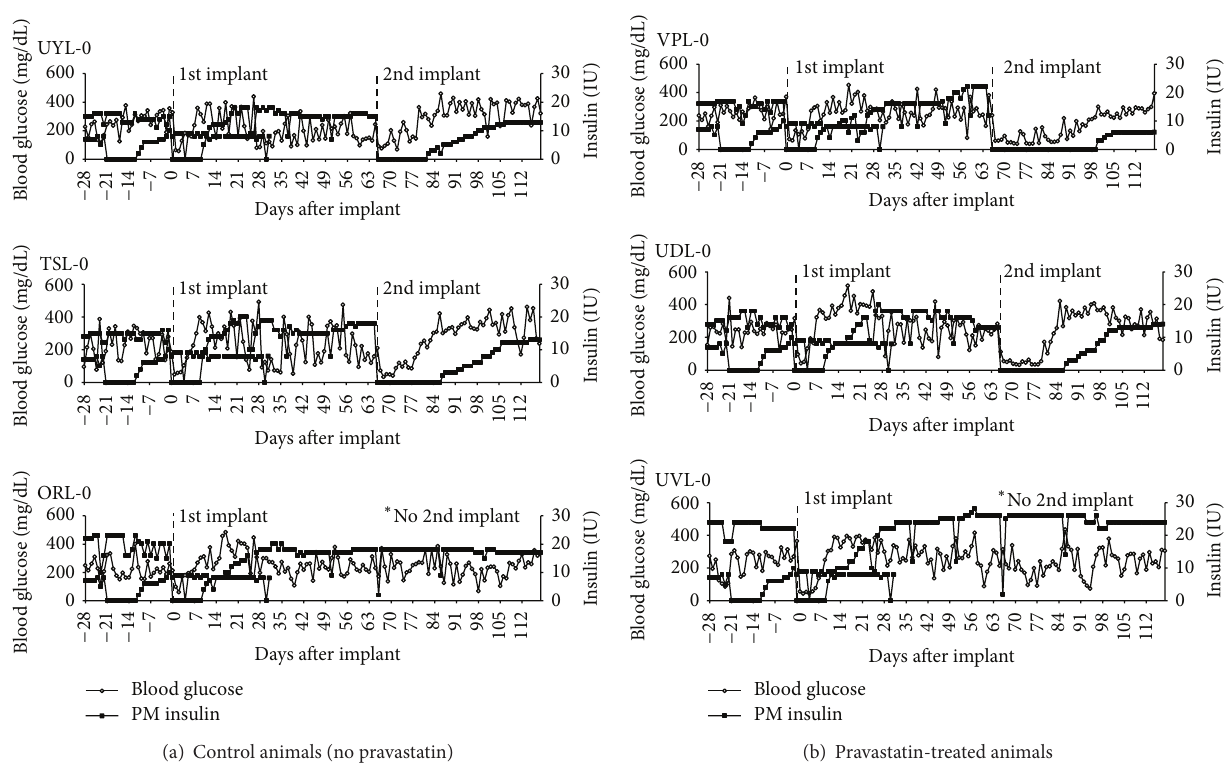
Figure 1: Blood glucose levels of study animals are shown as an average of daily AM and PM blood glucose levels (open circles). Exogenous insulin totals are graphed as a sum of daily AM and PM insulin units received (closed squares). Macrobead recipients that did not receive pravastatin (control animals) are shown in panel (a) (UYL-0, TSL-0, and ORL-0). Macrobead recipients that received daily pravastatin (80mg/day) are shown in panel (b) (VPL-0, UDL-0, and UVL-0). ORL-0 and UVL-0 did not receive a second porcine islet macrobead